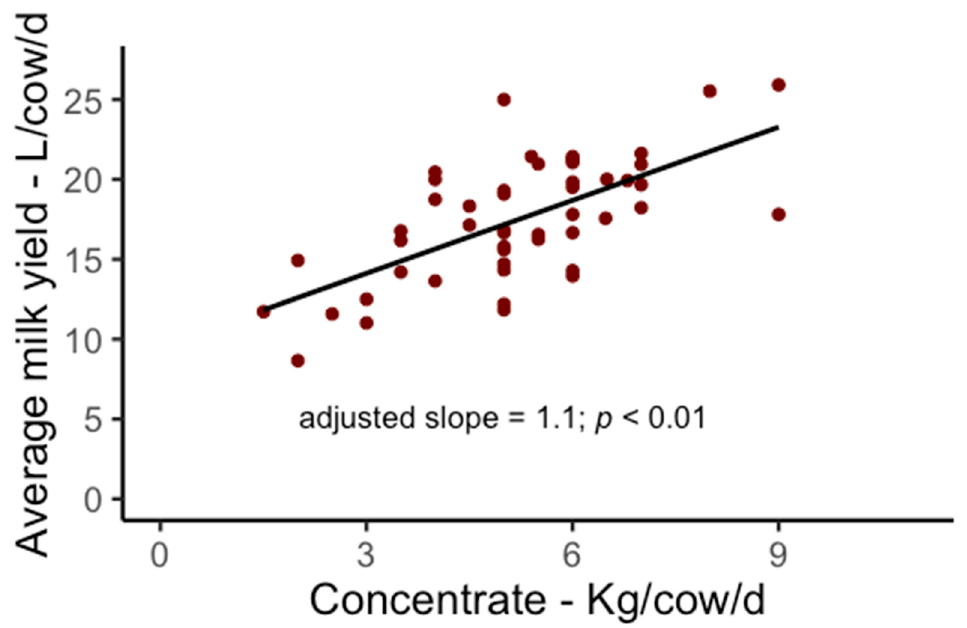
Figure 2. The effects of daily concentrate allocation per cow (kg/cow/d) on daily milk production (L/cow/d) on grazing dairy herds ( n = 48) in Santa Catarina State, Brazil. Dots represent the raw values summarizing the average of each farm.